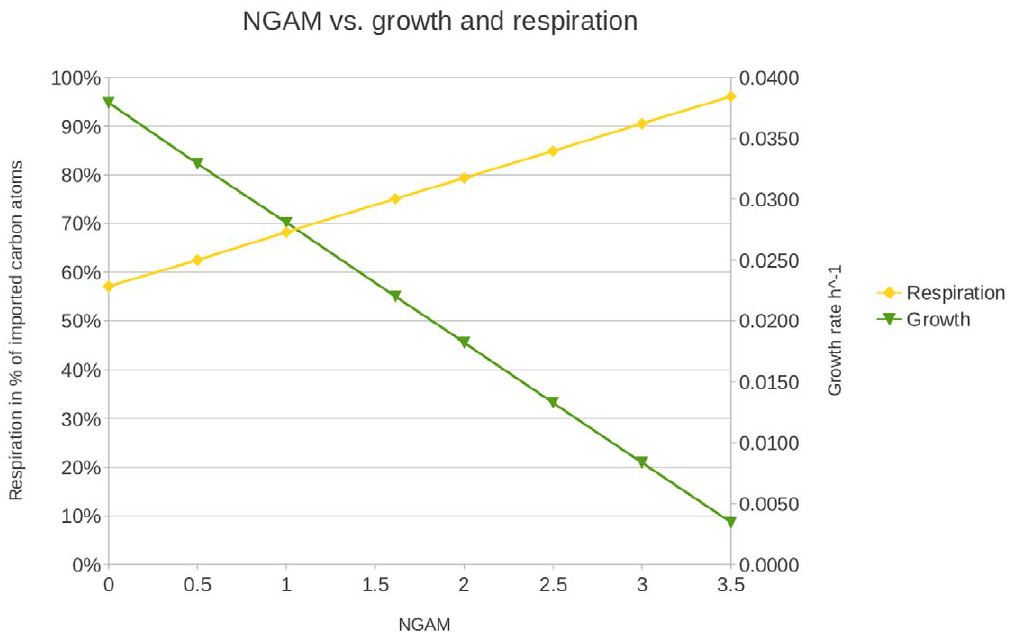
Figure 1. Diagram of the influence of non-growth-associated maintenance (NGAM) energy on the biomass flux and the respiration in S.solfataricus .